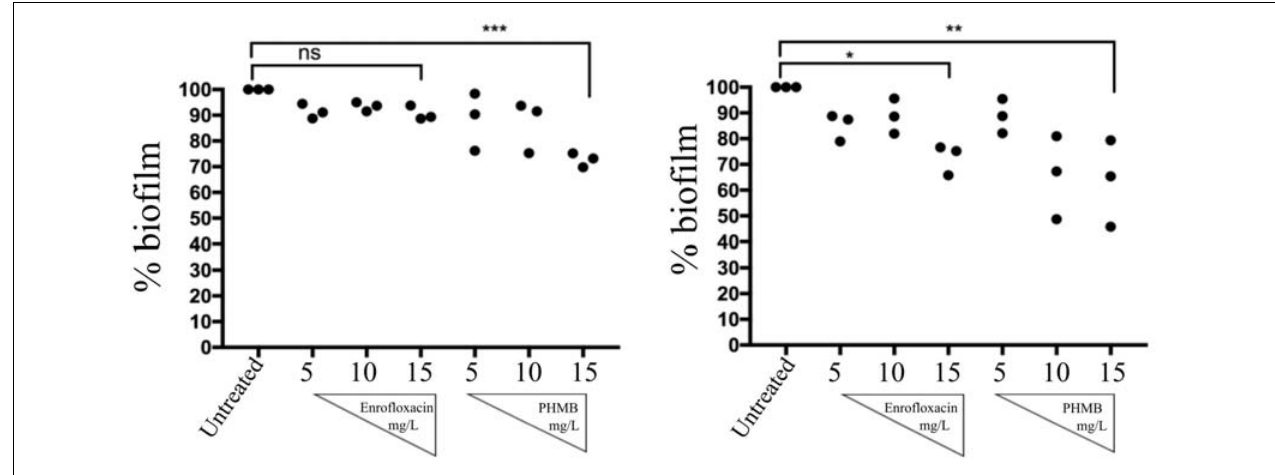
FIGURE 9 | Anti-biofilms activities of enrofloxacin and PHMB. Biofilms of S. aureus strain 15 AL and 59 were either untreated or treated with increasing concentrations of enrofloxacin or PHMB. Untreated biofilms were used as a positive control, corresponding to 100% biofilms’ mass.